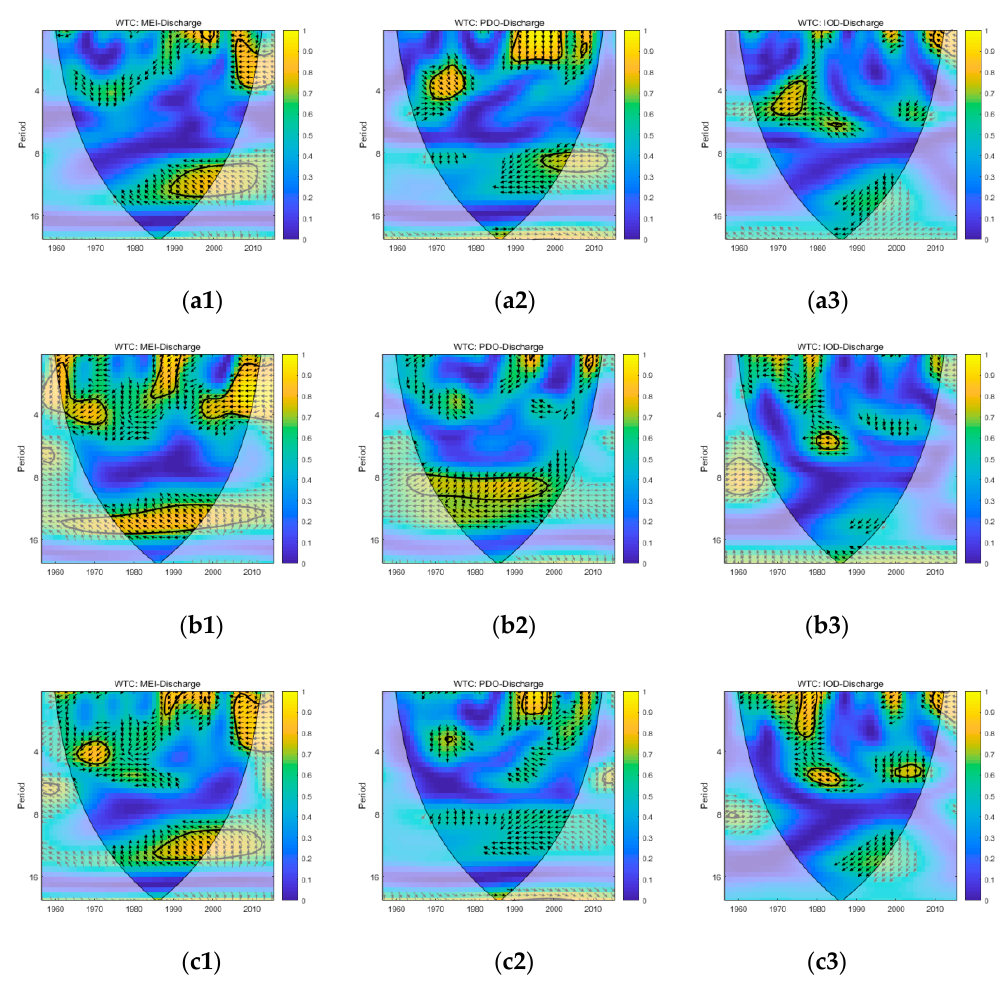
Figure 14. Wavelet coherence of discharge of three hydrological stations with MEI, PDO, IOD, respectively. (( a1 – a3 ) Nuxia station; ( b1 – b3 ) Nugesha station; ( c1 – c3 ) Yangcun station). The meaning in the figure is the same as in Figure 10.